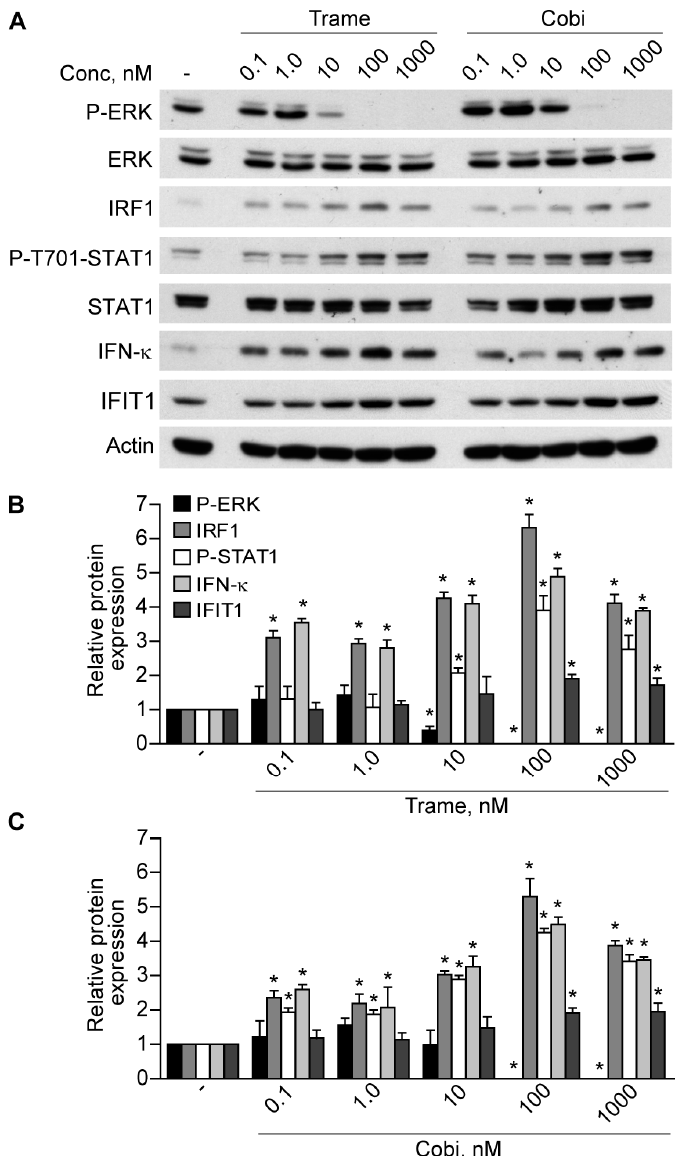
Figure 1. Trametinib and cobimetinib activate interferon regulatory (IRF1) and signal transducer and activator of transcription 1 (STAT1) dose-dependently. ( A ) Western blot analysis of total-cell extracts of normal human keratinocytes treated for 6 h with escalating doses of trametinib (Trame) and cobimetinib (Cobi). The protein species were detected at the expected molecular weights per their datasheets, as follows: extracellular signal-regulated kinases (ERK) 1/2), 44 and 42 kDa; IRF1, 48 kDa; STAT1 (STAT1, α / β isoforms), 91 and 84 kDa; actin, 43 kDa; interferon κ (IFN- κ ), 26 kDa; interferon-induced tetratricopeptide repeats 1 ( IFIT1), 56 kDa; ( B , C ) protein expression was analyzed in cells from different healthy donors ( n = 4). The ratios of phospho-ERK (P-ERK), IRF1, phospho-Tyr701-STAT1 (P-T701-STAT1), IFN- κ , and IFIT1 to their loading control (actin) were calculated and compared to the untreated condition ( − ). * p < 0.05. Data are expressed as the mean ± standard deviation (S.D.). Gene expression analysis confirmed dose-dependent up-regulation of IFN- κ transcript, which was statistically significant at 10 nM compared to untreated controls ( p < 0.05), and maximal at 100